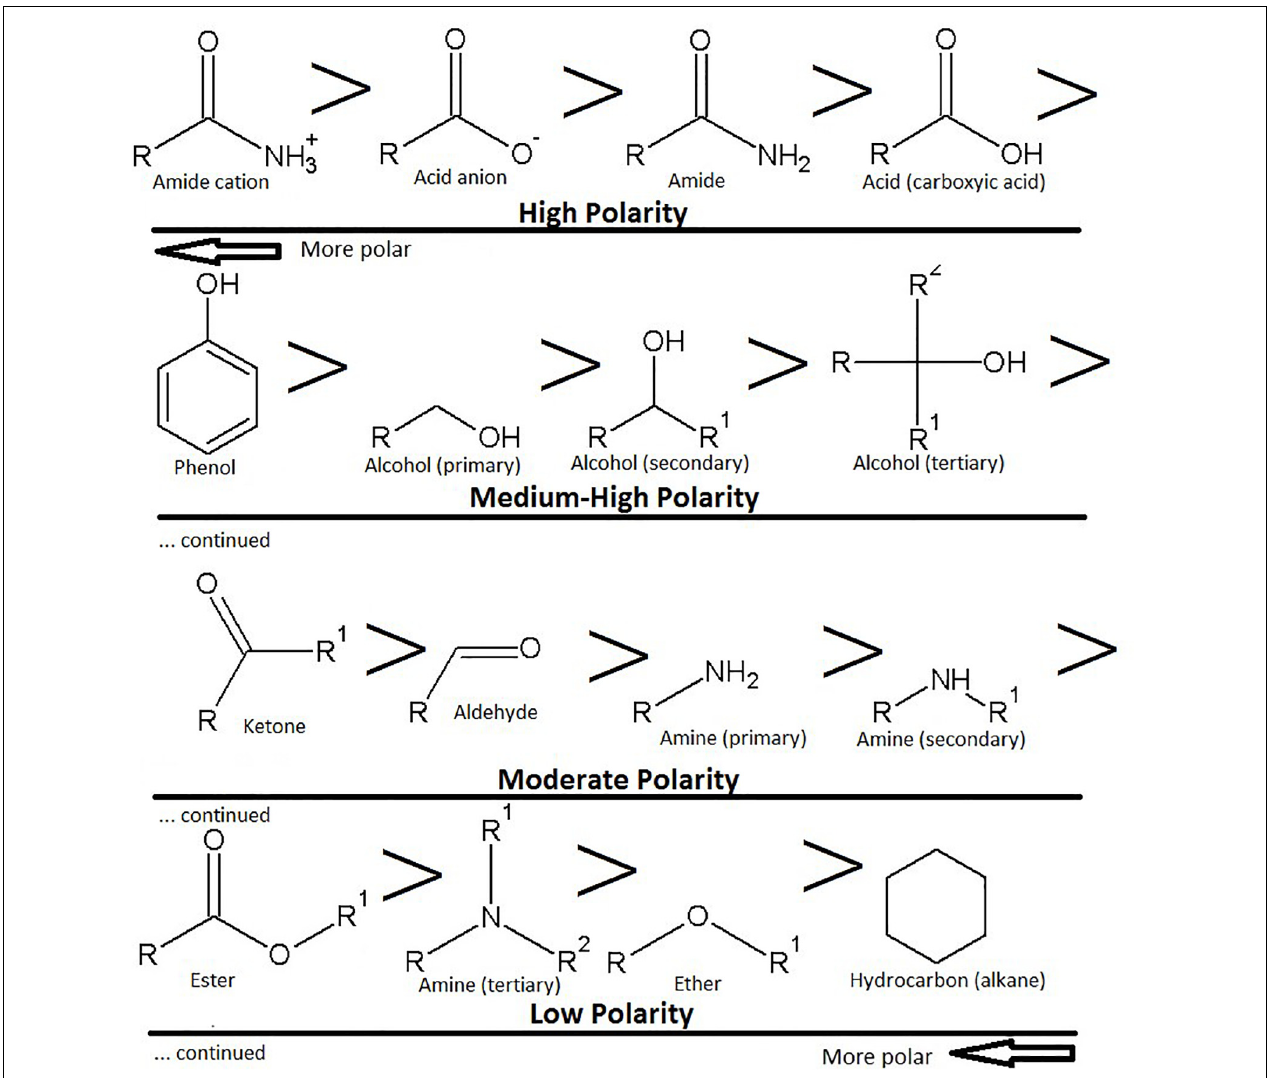
FIGURE 2 | Polarity of functional groups, with the most polar groups as acids and amides, plus their ionic counterparts. The highest polarity groups are toward the top left-hand side of the image, the lowest polarity groups are toward the bottom right hand side of the image. Note that amines can also be ionized.